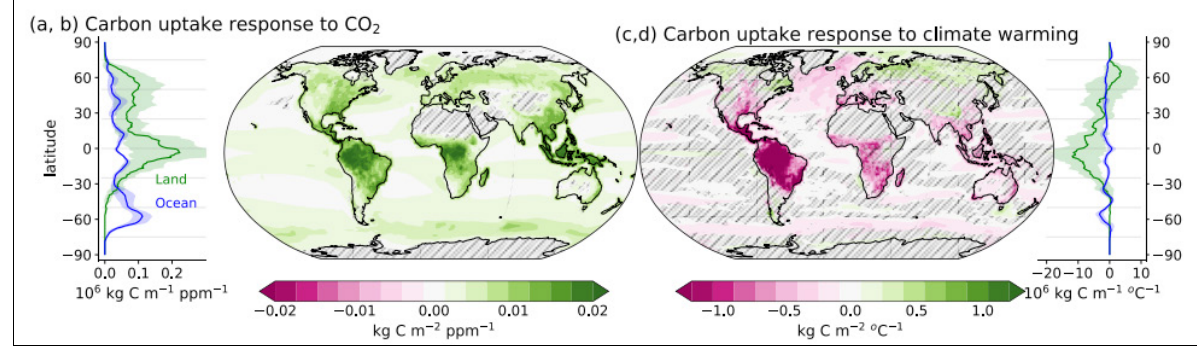
Source: From Box TS.5 Figure 1 of Arias et al. 21 Figure 3: Global and regional carbon cycle responses to carbon and climate forcing. Projected spatial and zonally integrated responses of terrestrial and ocean carbon sinks to carbon (a,b) and climate (c,d) forcing under a scenario of 1% increase in atmospheric CO ocean responses are mainly in the southern hemisphere mid- to high latitudes (blue in a,d) and terrestrial are mainly in the tropics and subtropics (green in